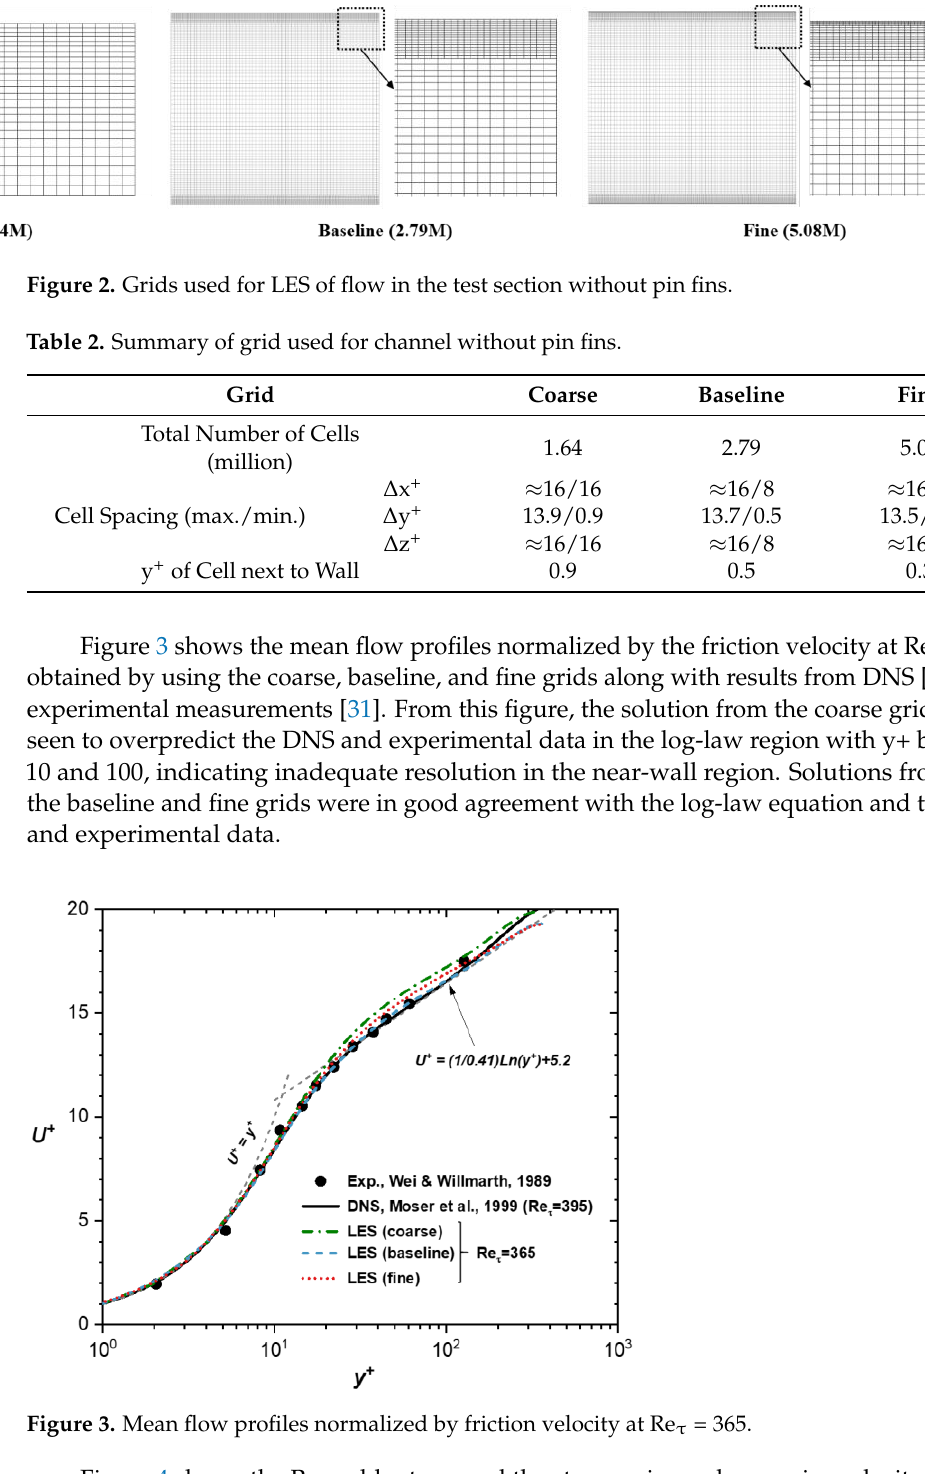
Figure 4. Mean flow fluctuations normalized by friction velocity at Re  = 365. Figure 5. Energy spectrum at (x, y) = (56.25H, 0.5D) obtained by the baseline grid.